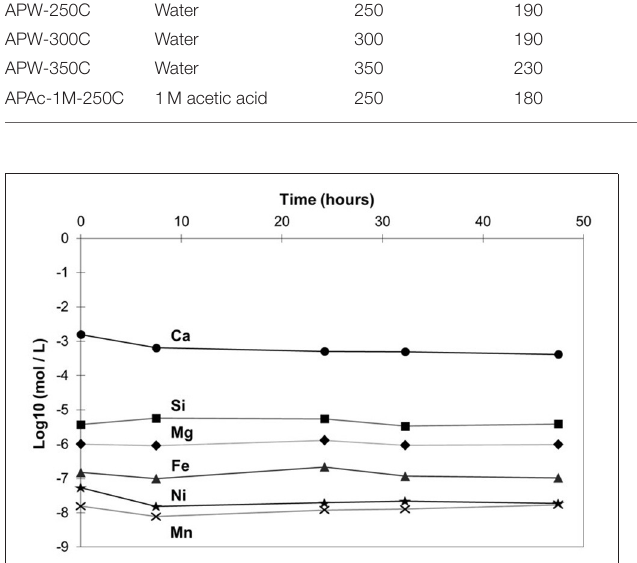
FIGURE 2 | Evolution of the concentration of the main dissolved species in quenched solutions of the hydrothermal oxidation experiments of steel slag at 300 ◦ C ( APW-300C) : Ca (circles), Si (squares), Mg (diamonds), Fe (triangles), Ni (stars), Mn (crosses). ICP-OES data (moles per liter) are displayed in log 10 units. Estimated errors are not displayed since they would not exceed symbol